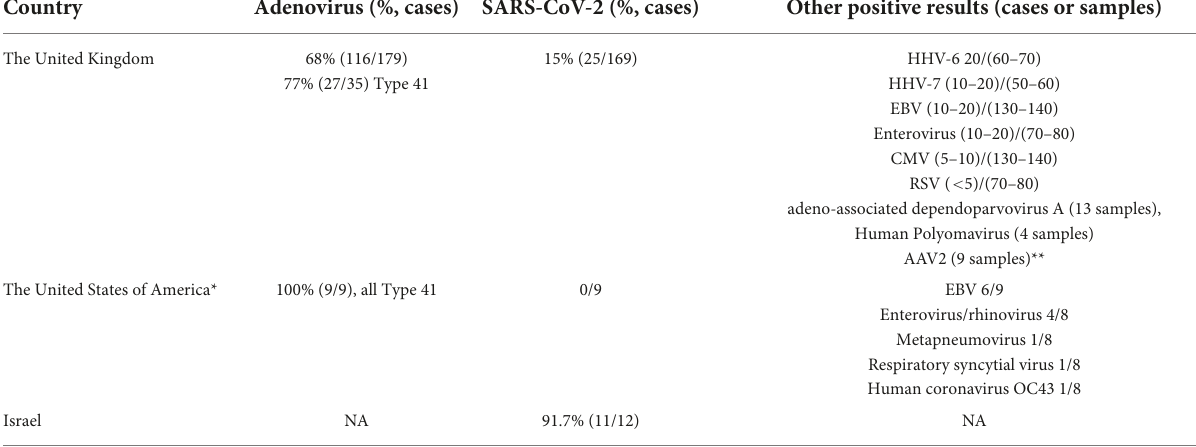
TABLE 3 Summary of the possible infectious causing factors observed in cases of hepatitis of unknown etiology in different countries. Country Adenovirus (%, cases) SARS-CoV-2 (%, cases) Other positive results (cases or samples) The United